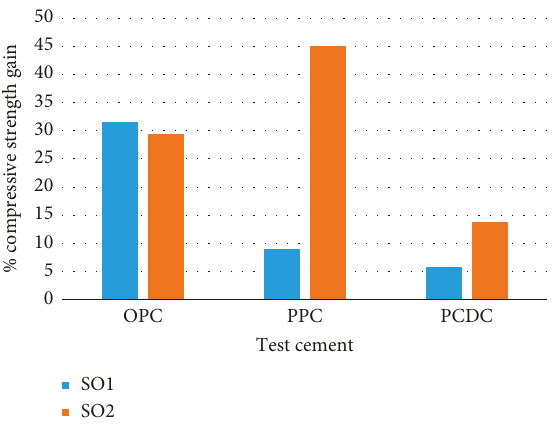
Figure 26: Percent gain in compressive strength versus test cement.